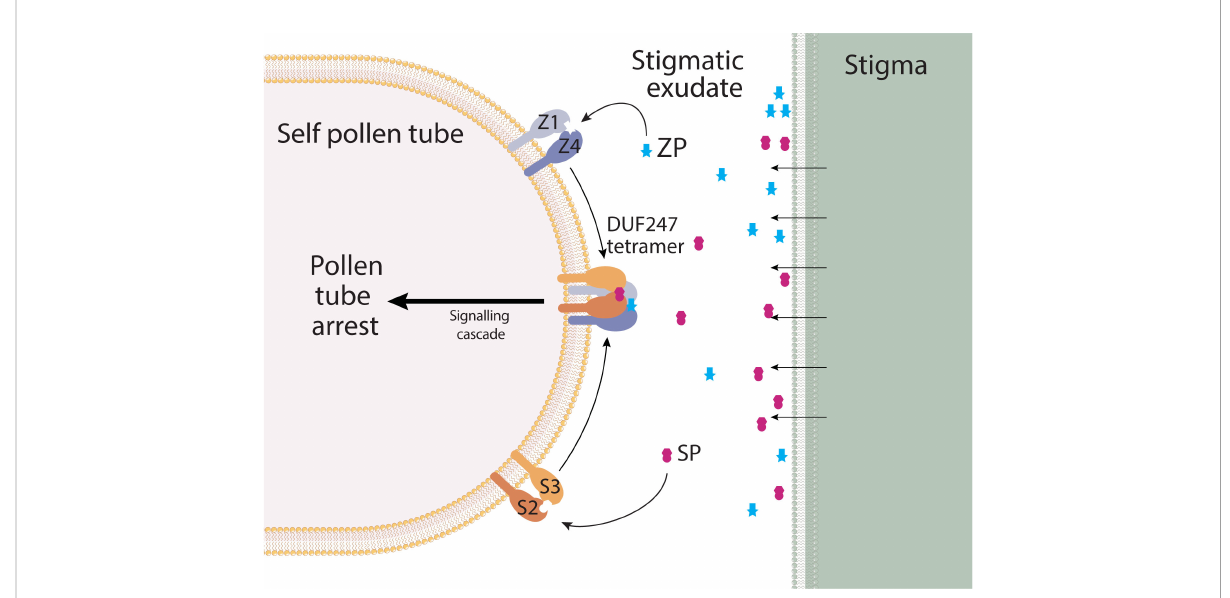
FIGURE 8 Model for SI in grasses. DUF247 proteins from S- and Z-loci form dimers at the pollen tube surface, and are anchored to the membrane by a conserved transmembrane domain. SP/ZP peptides are free- fl oating in the stigmatic exudate, allowing pollen tube arrest to occur immediately upon pollen germination. Signals from S- and Z- must be incorporated, therefore we propose a tetramerization of DUF247 proteins, resulting in a downstream signaling cascade that results in pollen tube arrest. Absence of any component, or non-self components would result in a lack of signaling, thus allowing pollen tube